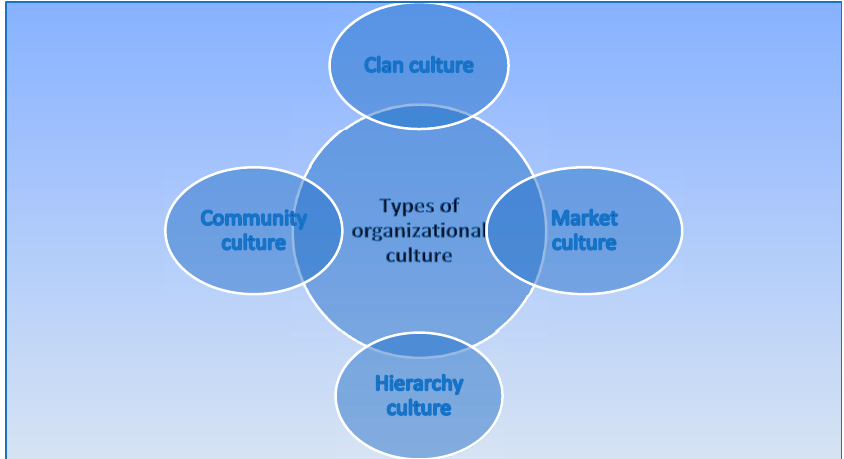
Figure 1. Types of organizational culture. Figure created by the author.